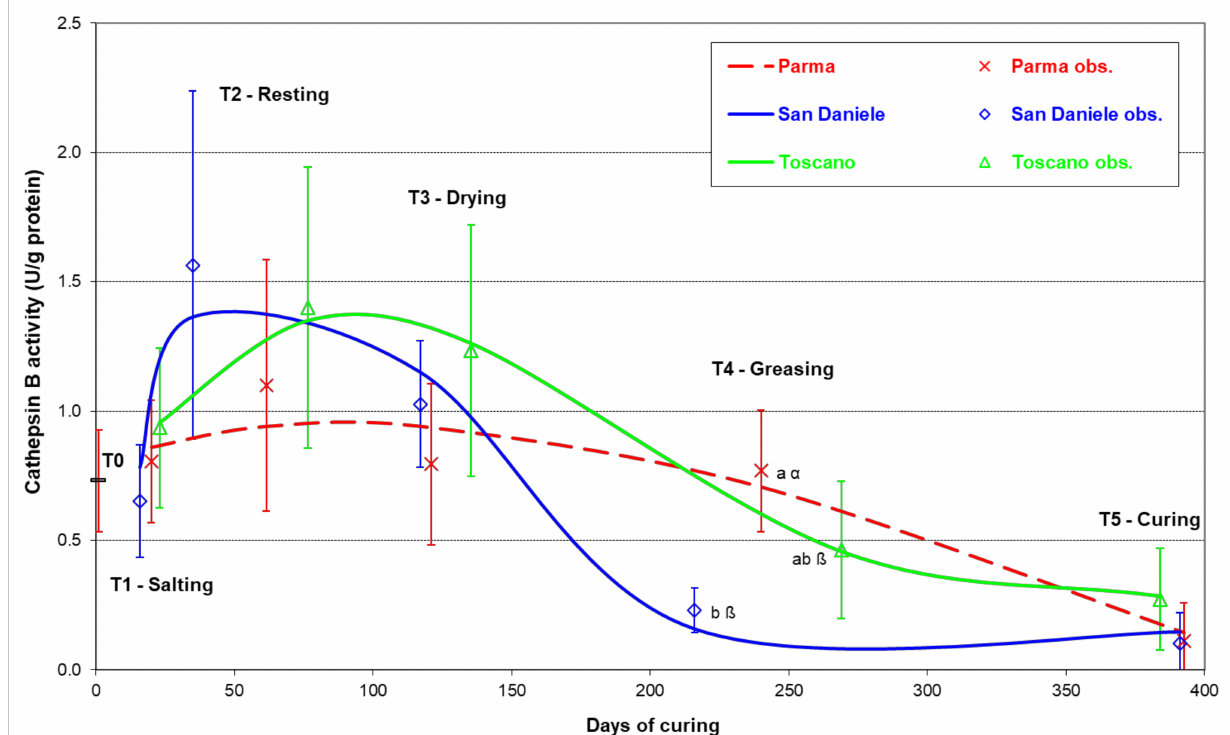
Figure 4. Evolution of the Cathepsin B activity in the biceps femoris muscle during the processing of the main Italian prosciutto PDOs (obs. = observed mean with standard deviation values; a, b: differences between PDOs within a ripening phase p ≤ 0.05; α , β : differences between PDOs within the ripening phase p ≤ 0.10).